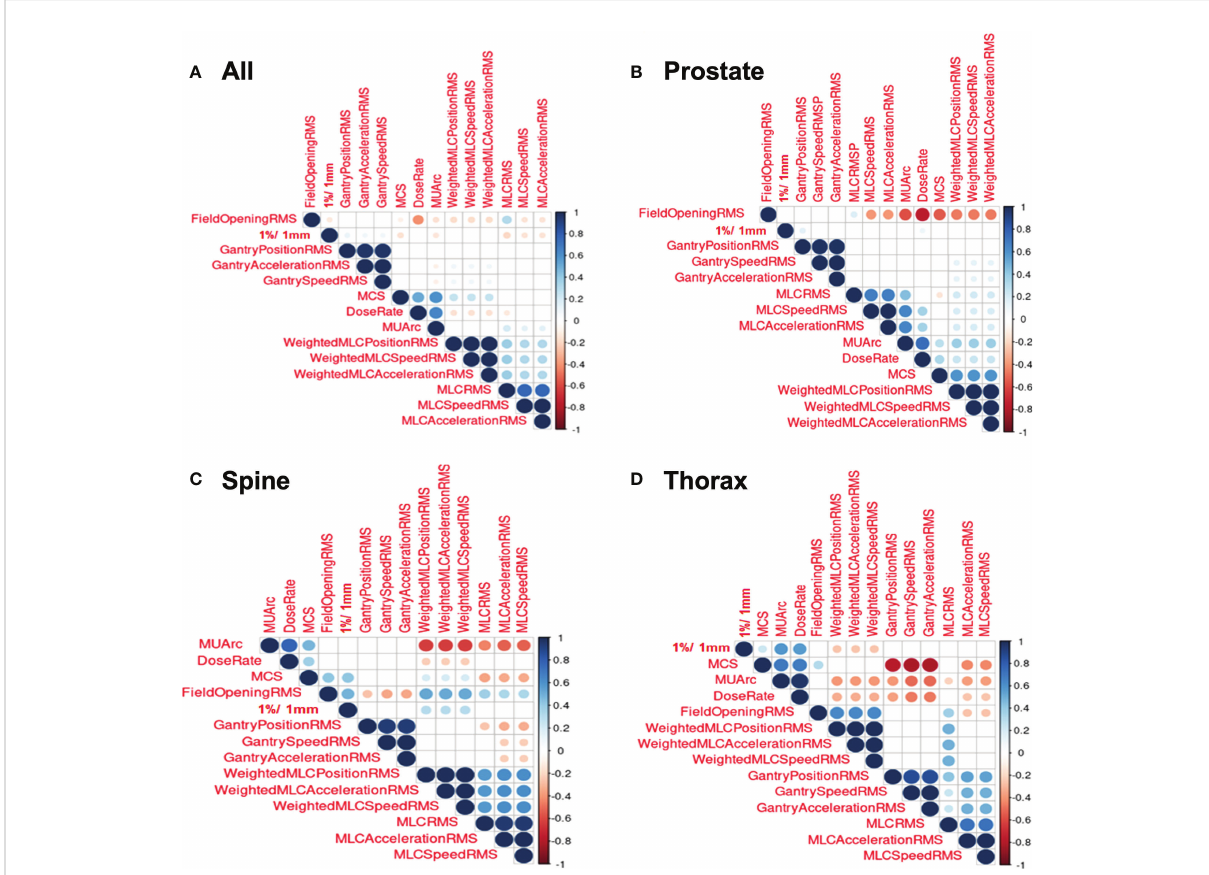
FIGURE 3 Correlation Plots for Log File. (A) Correlation plot for all log fi les. (B) Correlation plot for prostate log fi les. (C) Correlation plot for spine log fi les. (D) Correlation plot for thorax log fi